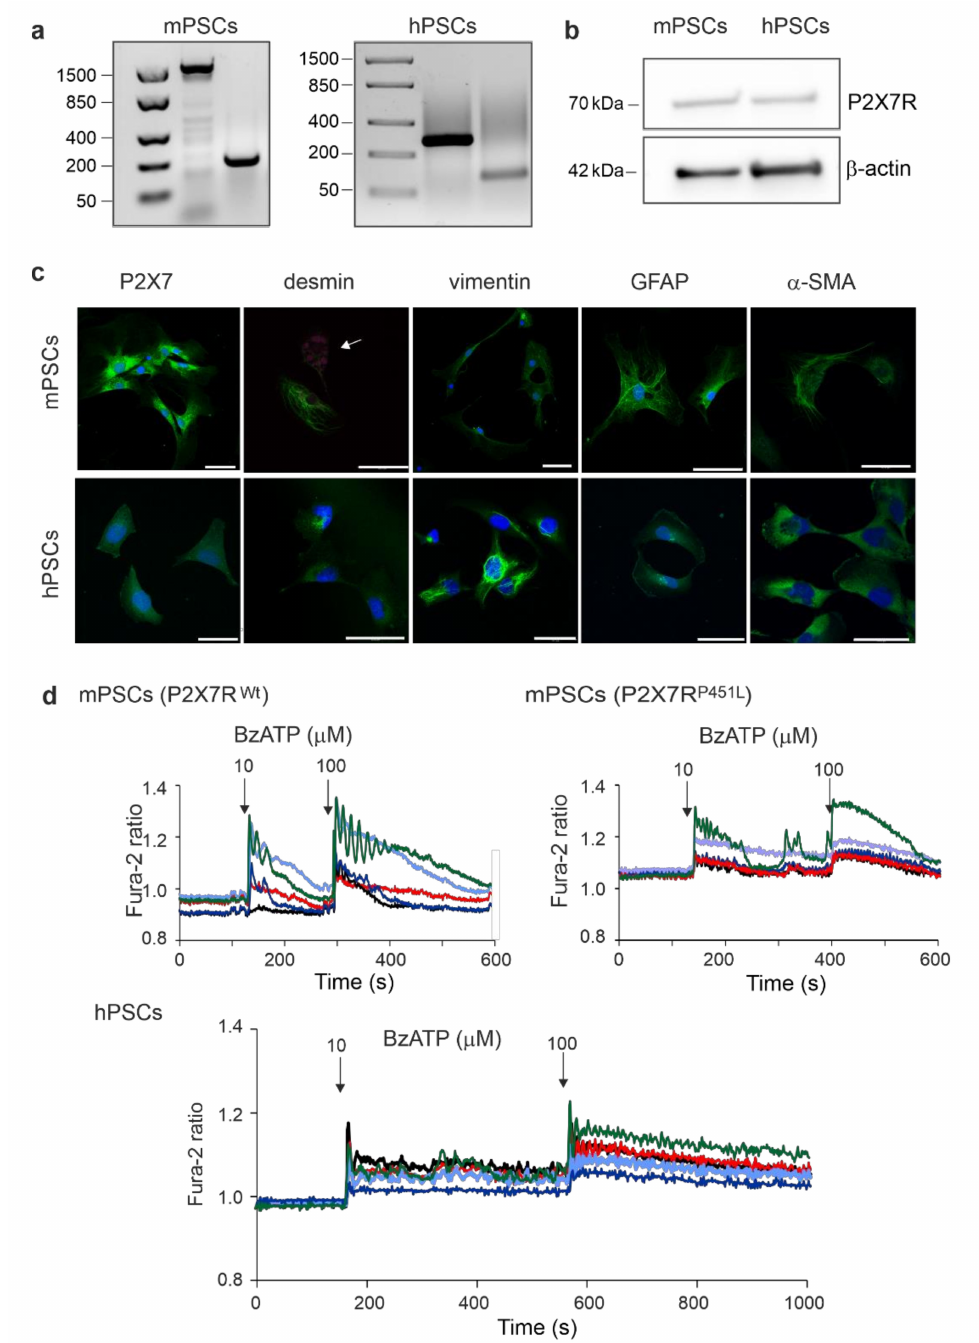
Figure 1. Expression of P2X7R, PSC markers and calcium signals in mPSCs and hPSCs. ( a ) RT-PCR results with different pairs of primers for the P2X7R (Table 1). ( b ) Representative blots of P2X7R (70 kDa) isoform A and the loading control β -actin. ( c ) Immunofluorescence detection of P2X7R and the PSC markers desmin, vimentin, GFAP and α -SMA. Image of mPSCs stained for desmin also shows less activated/quiescent cells with autofluorescent lipid droplets (arrow). Scale bar is 50 µ m in all images. ( d ) Fura-2 ratio in PSCs after consecutive stimulation with 10 µ M BzATP and 100 µ M BzATP. The graph shows 5 representative cells out of 10–20 cells recorded per experiment, 6